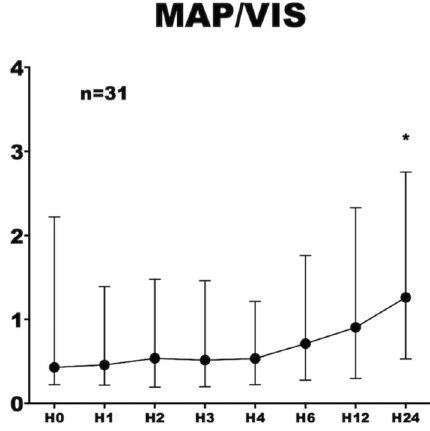
Fig. 1 Evolution of MAP/VIS ratio among shocked patients at baseline F‑063 Liver Dysfunction and Ketamine use in critically ill patients with ARDS: a Post Hoc analysis of the ACURASYS study